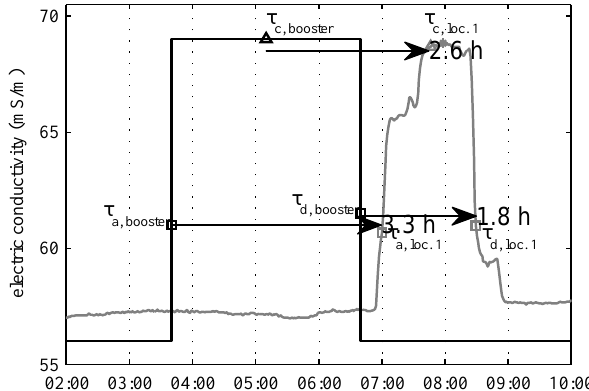
Figure 3. Reconstructed EC at booster locations and measured EC at location 1 (Wednesday, 3 September 2008) plus associated travel times.